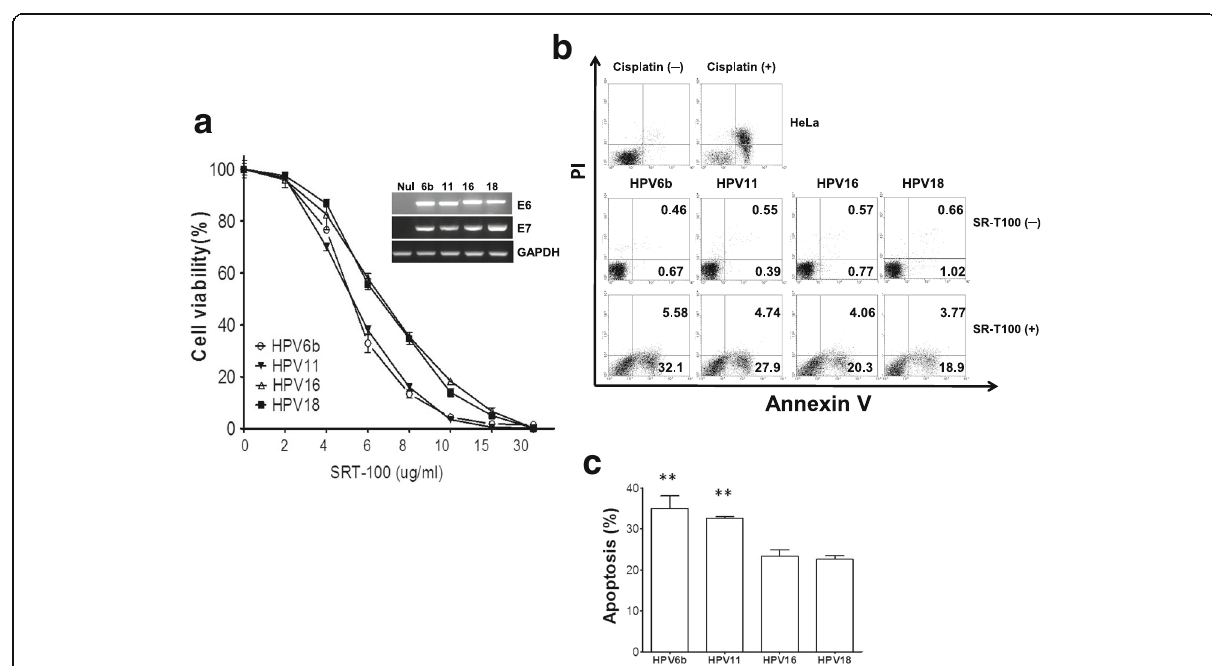
Fig. 1 SR-T100 induced different levels of growth inhibition and apoptotic cell death in primary epithelial cells expressing different types of HPV- E6/E7. a After infection with different types Lenti-HPVE6/E7 viruses, the primary epithelial cells were treated with the indicated concentrations of SR-T100 for 24 h. Cell viability was determined using the CellTiter-Glo® luminescent cell viability assay. Each value represents the mean ± SD of three determinations. HPV-E6/E7 expression in normal cervical epithelial cells was confirmed by RT-PCR as shown in the inset panel. b HeLa cells were treated with cisplatin (150 μ M) for 24 h (upper panel) and used as a positive control. After infection with different types of Lenti-HPV-E6/E7 viruses, the primary epithelial cells were treated with SR-T100 (5 μ g/ml) for 12 h and double labeled with Annexin V-FITC and propidium iodide (PI). In the cytograms from three experiments, the apoptotic cells (Annexin V-positive) are distributed in the lower and upper right panels (the values are reported as percentages). c Histograms showing the number of apoptotic primary epithelial cells expressing different types of HPV-E6/ E7. The results shown are the mean values of three independent experiments; bars, ±SD. ** p < 0.01, HPV6 or HPV11 versus HPV16 or